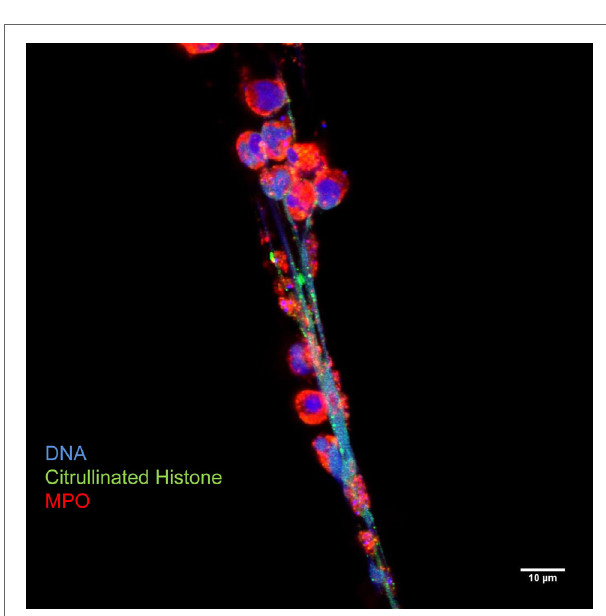
FiGURe 3 | Neutrophil extracellular traps are characterized by decondensed latices of DNA with citrullinated histones decorated with neutrophil granules proteins, such as myeloperoxidase . Originally published by Maugeri et al. (20).